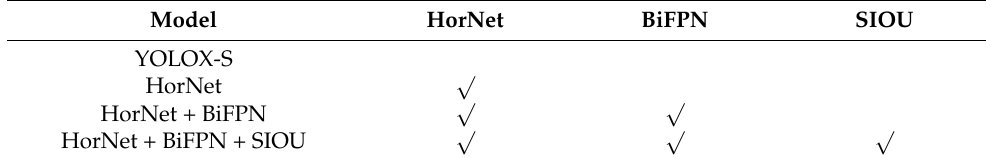
Table 1. Various module combinations are displayed; “